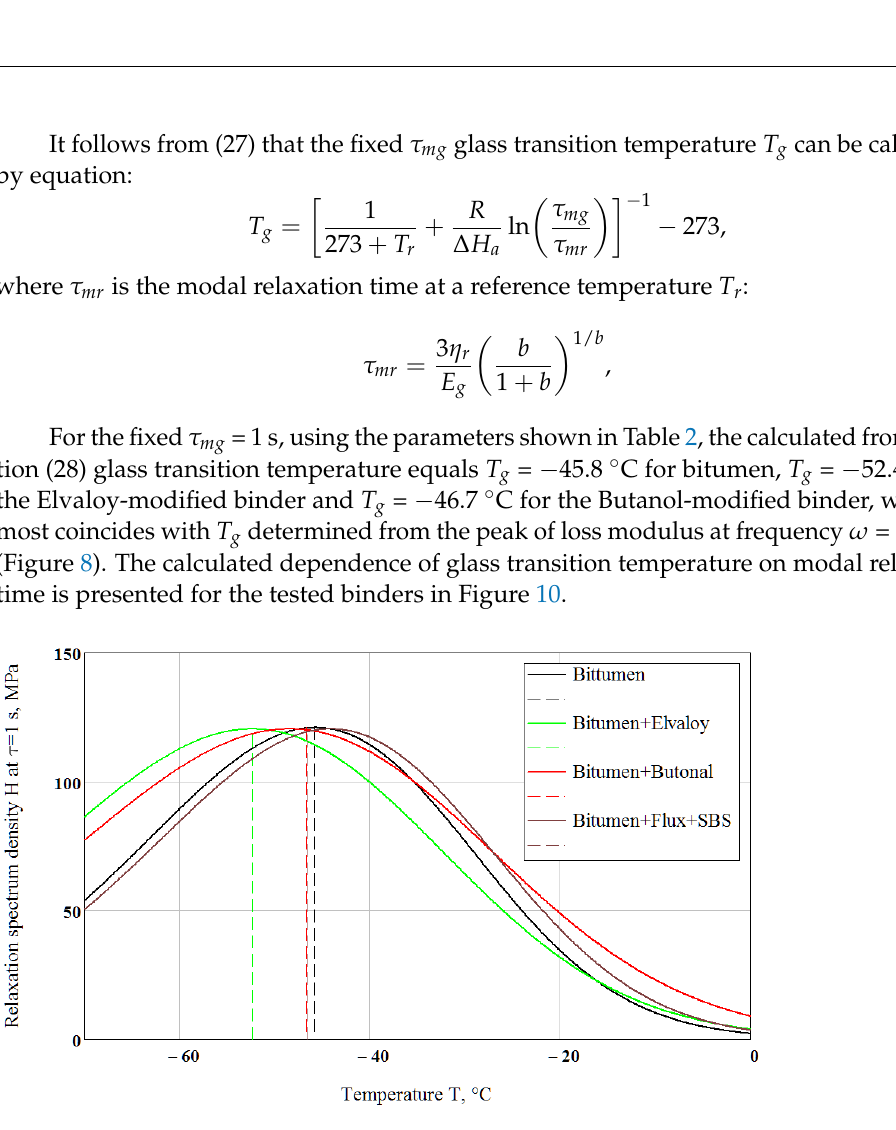
Figure 9. Definition of the glass transition temperatures for the binders using relaxation spectrum density at the modal relaxation time τ m = 1 s.